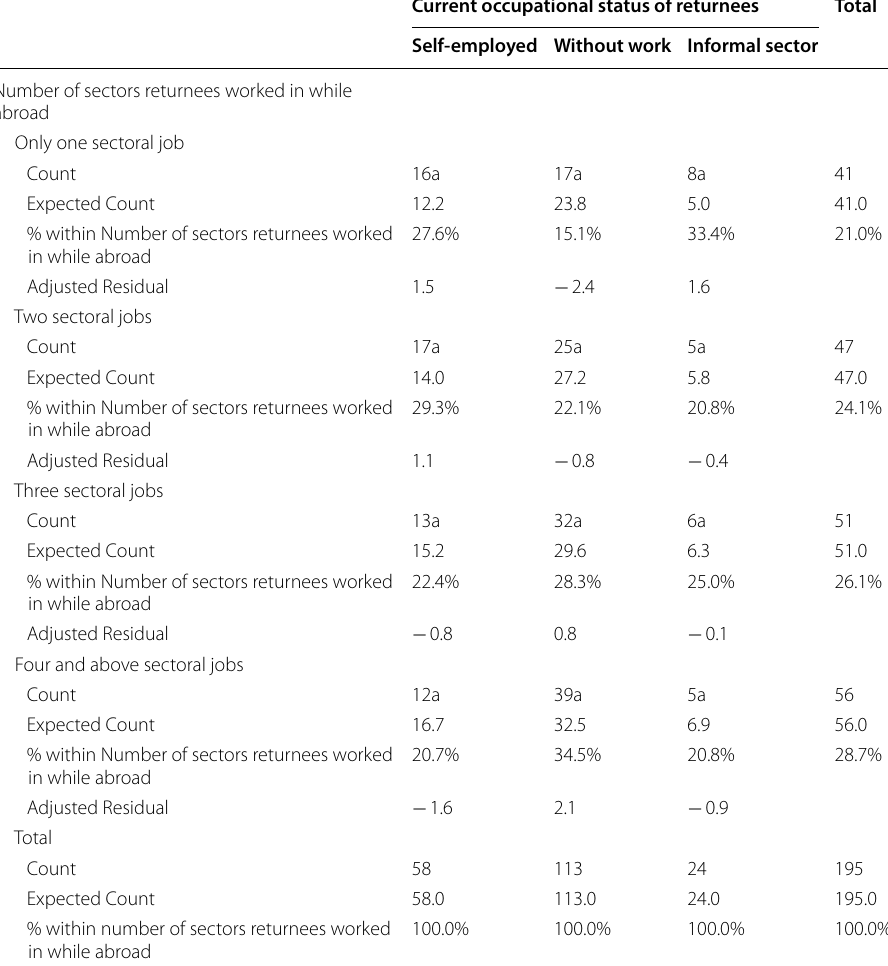
Source field survey result, 2021